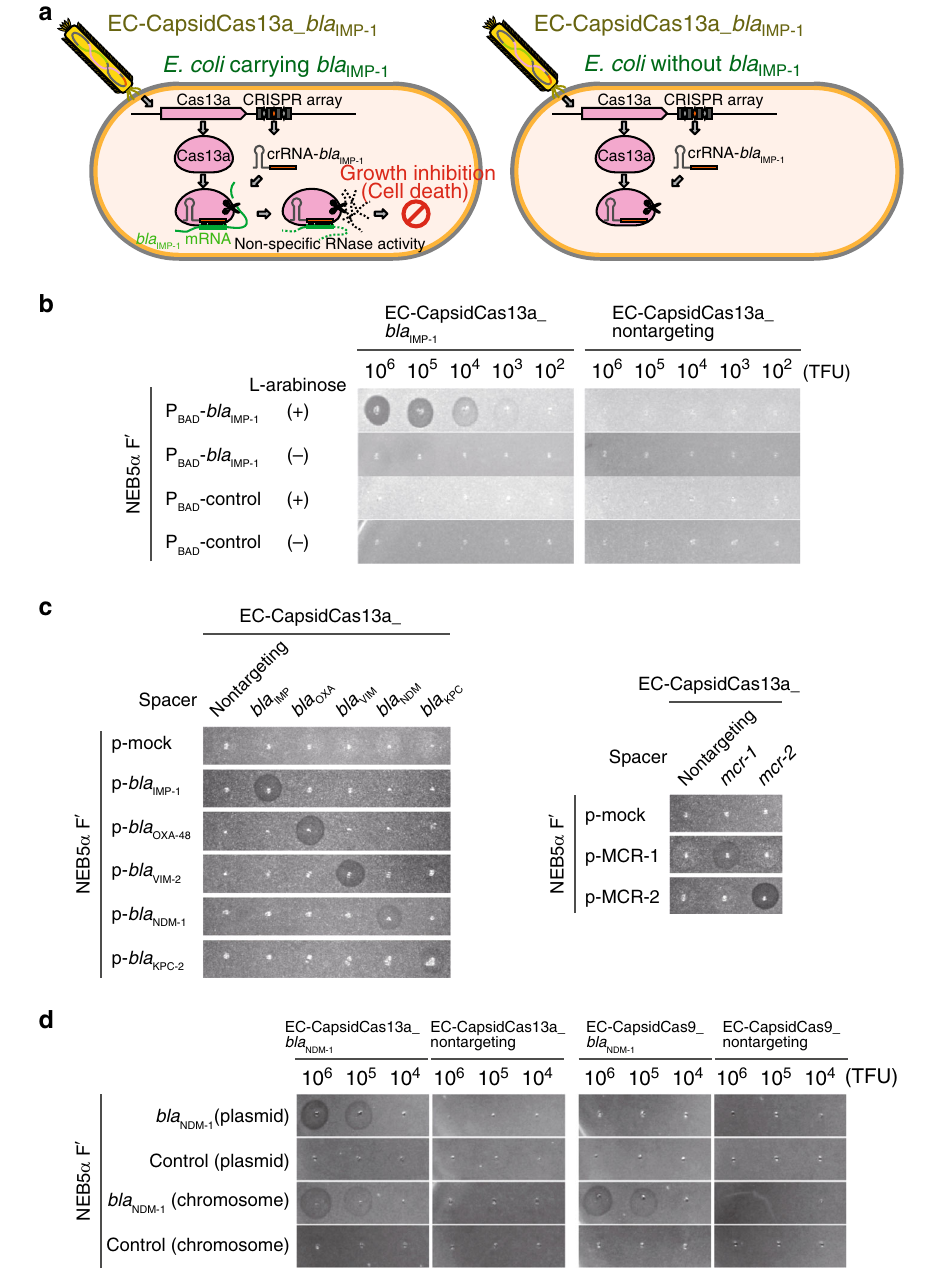
Fig. 2 In vivo sequence-speci fi c bactericidal activity of CapsidCas13a. a Graphical concept model depicting the mode of action of CapsidCas13a, with bla E. coli M13 phage capsid (EC-CapsidCas13a- bla IMP-1 -targeting CRISPR-Cas13a packaged into IMP-1 ) for delivery into host bacterial cells during the normal course of viral infection. In the presence of the target gene ( E. coli carrying bla IMP-1 ), CRISPR-Cas13a will be activated and the subsequent non-sequence- speci fi c RNase activity will result in host cell death. In the absence of the target gene ( E. coli without bla IMP-1 ), CRISPR-Cas13a will not be activated and there will be no subsequent cell death. b – d Spot assay with generated CapsidCas13a(s) on bacterial lawn of E. coli NEB5 α F ′ I q to test bactericidal activity. A clear lysis zone of the spotted area represents bacterial killing. NEB5 α F ′ I q carrying bla IMP-1 expression vector and empty vector (control) were infected with tenfold serial dilutions of EC-CapsidCas13a- bla IMP-1 in the presence or absence of L-arabinose for inducing bla IMP-1 expression ( b ); CapsidCas13a(s) programmed to target different carbapenem resistance genes ( bla IMP-1 , bla OXA-48 , bla VIM-2 , bla NDM-1 , and bla KPC-2 ) and colistin resistance genes ( mcr-1 and mcr-2 ) were spotted on a series of NEB5 α F ′ I q strains expressing each of the resistance genes ( c ); comparison of bactericidal activity between CRISPR-Cas9 and CRISPR-Cas13a. Nontargeting and bla NDM-1 -targeting CapsidCas13a and CapsidCas9, in tenfold serial dilutions, were spotted on lawn of NEB5 α F ′ I q with or without expression of bla NDM-1 on plasmid or chromosome ( d ). All assays were replicated three